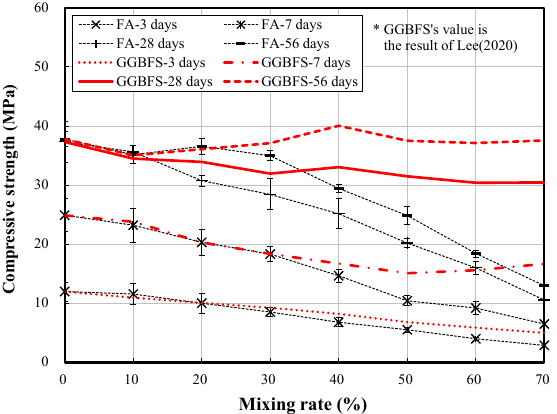
Figure 9. Results of the compressive strength of OPC and FA compared with GGBFS as measured by Lee (adapted from [26]) in terms of the mixing rate.